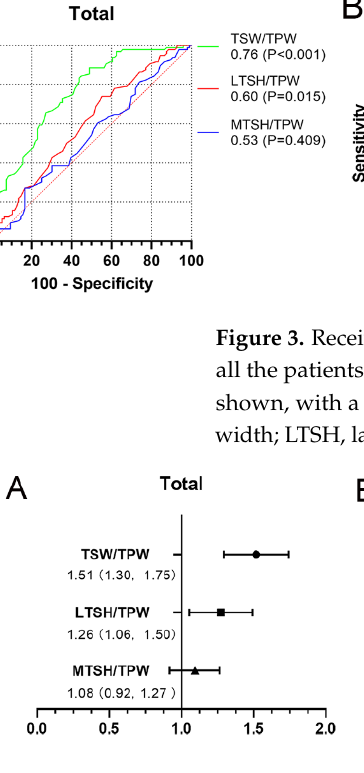
Figure 4. The specific relationships between tibial spine morphologies and ACL injury in all the patients together ( A ), in males ( B ), and in females ( C ), showing the odds ratio and a 95% confidence interval. TSW, tibial spine width; LTSH, lateral tibial spine height; MTSH, medial tibial spine height; TPW, tibial plateau width.